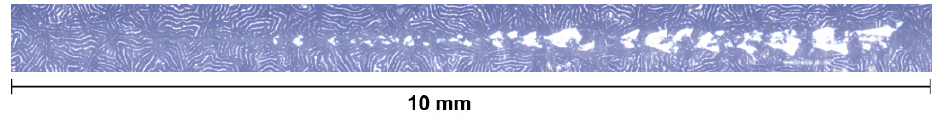
Figure 5. Average friction coefficient (µ) courses in the scratch test.